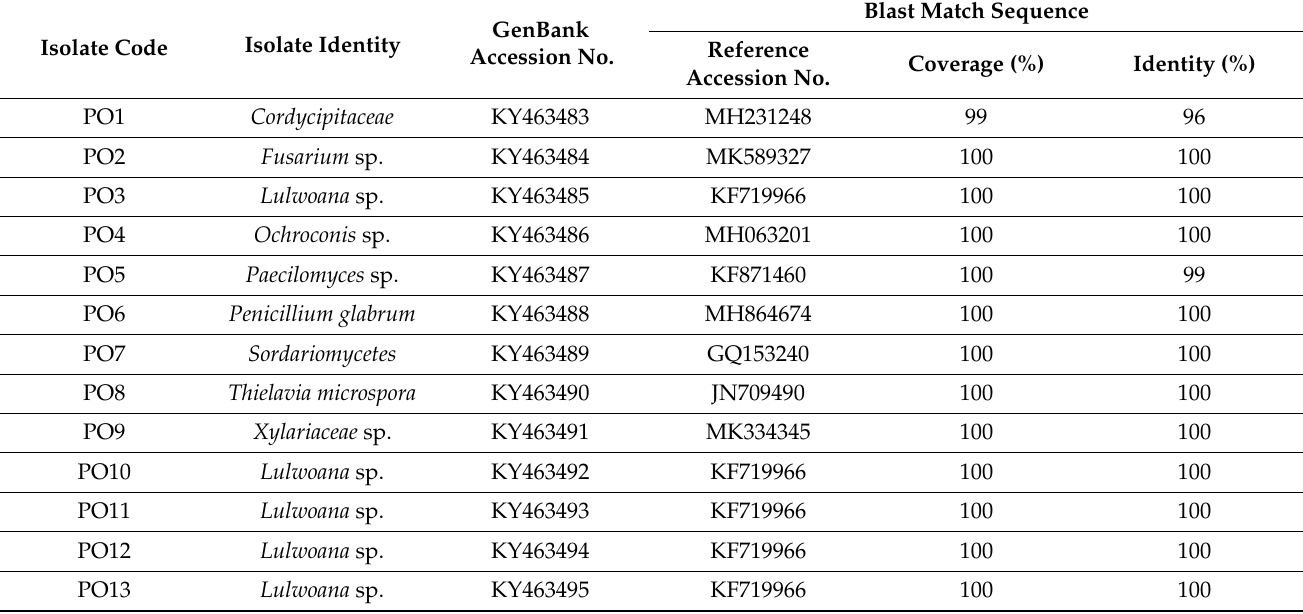
Table 1. List of fungal endophytes isolated from Posidonia oceanica meadows in three Sicilian seas with their corresponding GenBank accession numbers and Blast results, obtained from